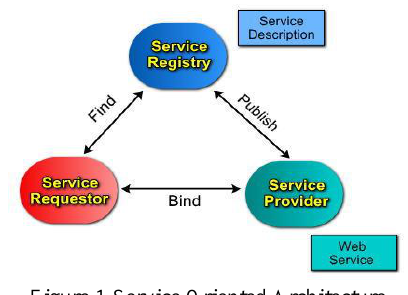
Figure 1.Service Oriented